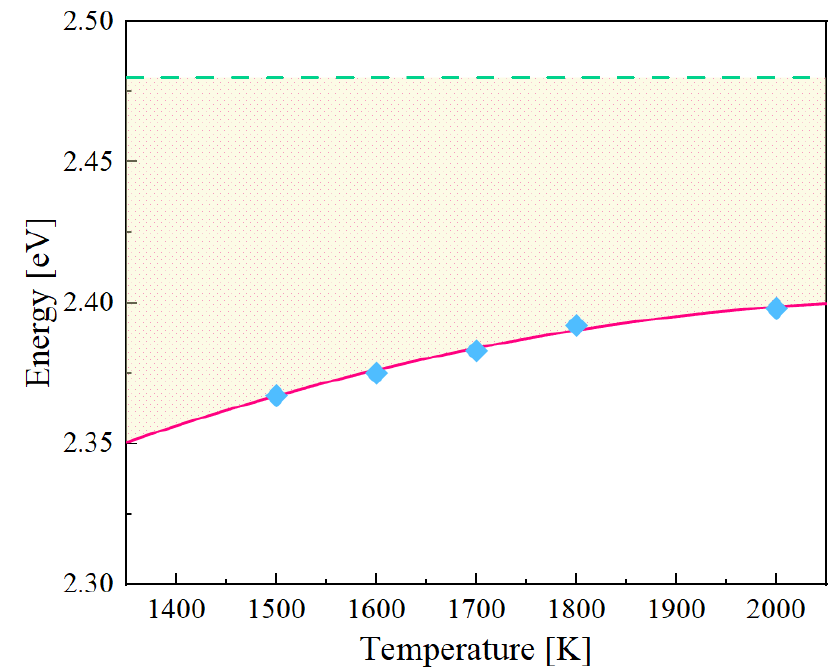
Figure 5. Effective vacancy formation energy as a function of temperature. The horizontal line represents the statistical average in the vacancy formation energy distribution of the random Nb-Mo- Ta-W bulk. The shadow region highlights the difference between effective energies and the statistical average value.